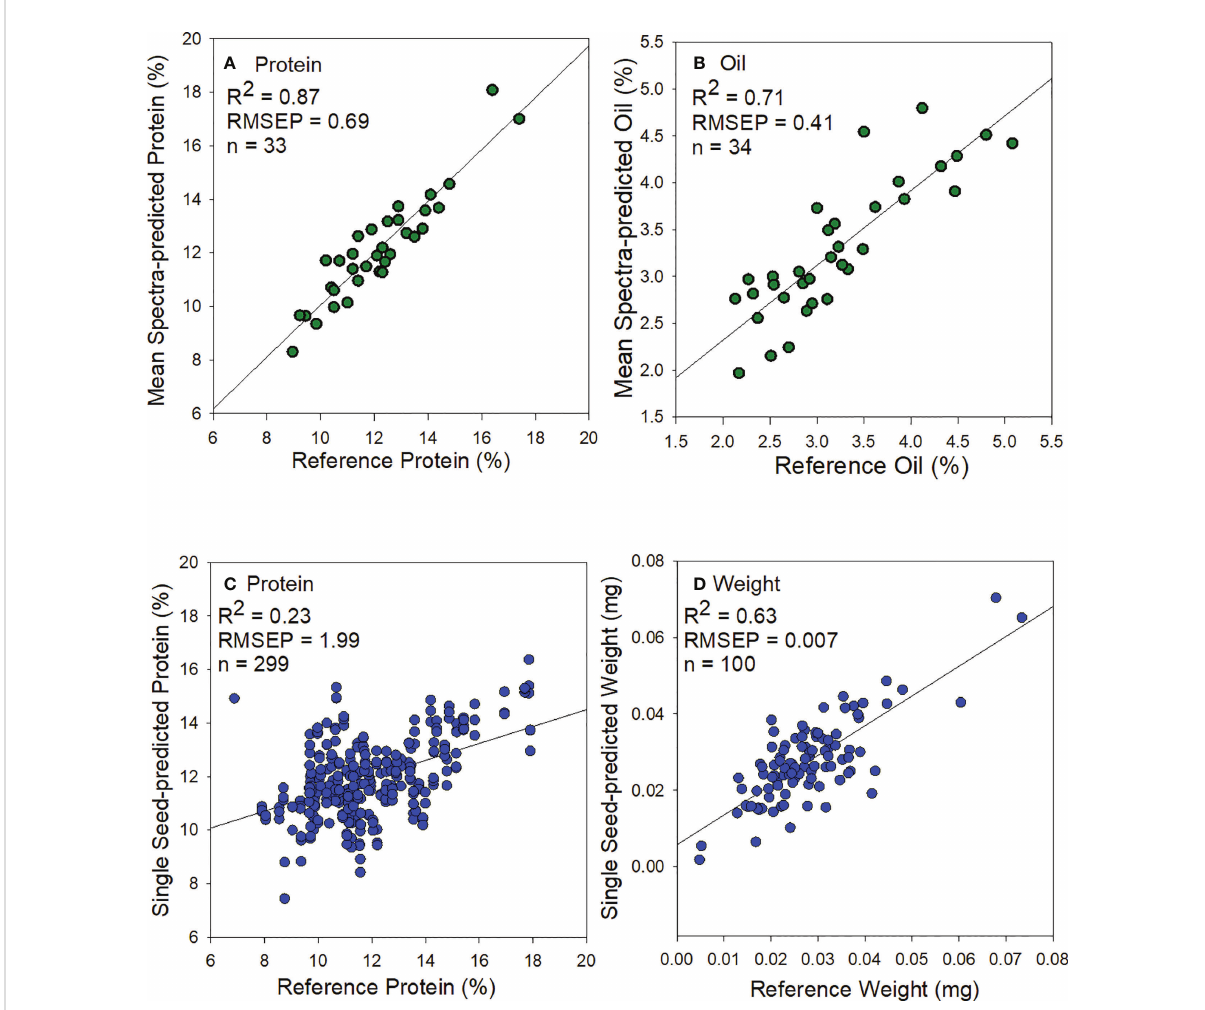
FIGURE 4 Scatter plots of predicted and analytically wet-lab measured (A) protein from using mean spectra, (B) oil from using mean spectra, (C) protein from single sorghum seeds, and (D) weight from single sorghum seeds.